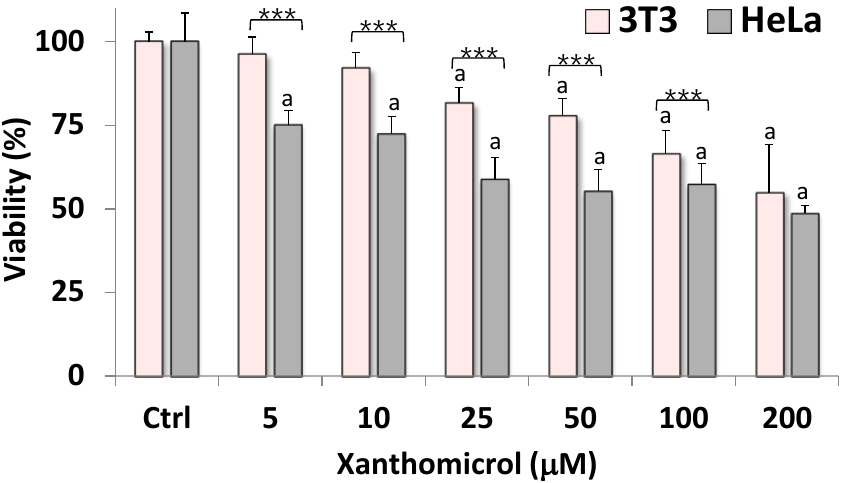
Figure 2. Viability (MTT assay) expressed as % of the control (Ctrl), induced by incubation for 24 h with different amounts (5 – 200 μM) of xanthomicrol 1 in cancer HeLa cells and 3T3 fibroblasts. Three independent experiments were performed, and data are presented as mean ± SD (n = 16); a = p < 0.001 versus Ctrl (One-way ANOVA and Bonferroni post-test); *** = p < 0.001 for Hela cells versus 3T3 fibroblasts (Student ’ s unpaired t-test with Welch ’ s correction).